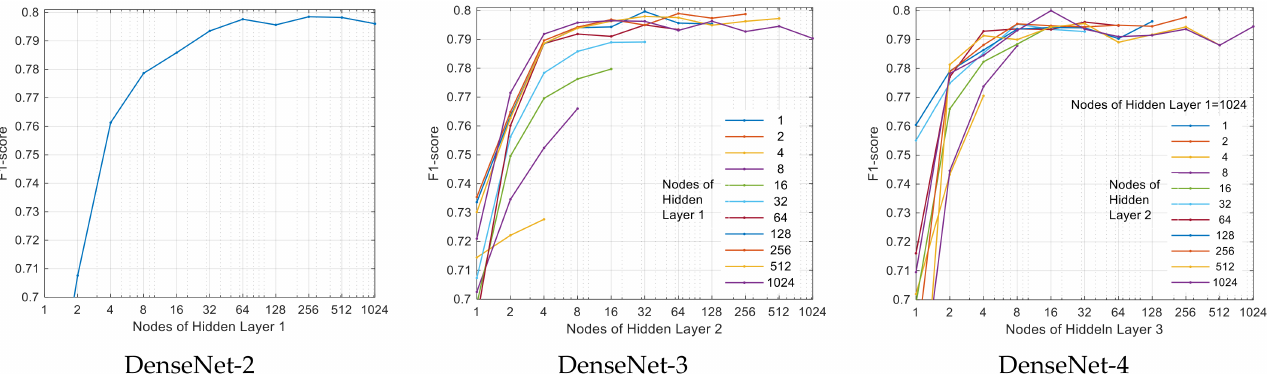
Figure 4. Performance of all NN architectures in the grid search with two (DenseNet-2), three (DenseNet-3) and four (DenseNet-4) dense layers in function of the number of nodes of the last hidden